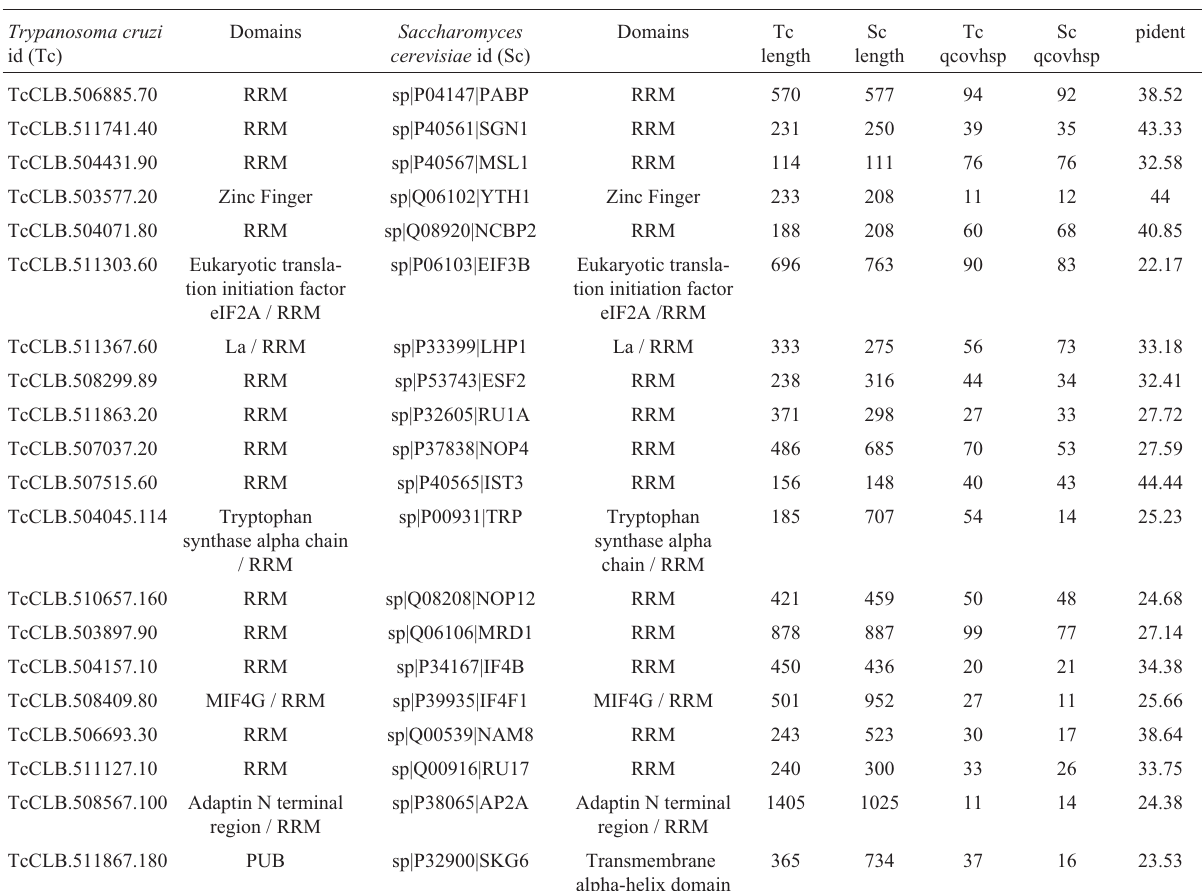
Table 2 - Orthology analysis of RNA-binding proteins between T. cruzi and S. cerevisiae. Trypanosoma cruzi id